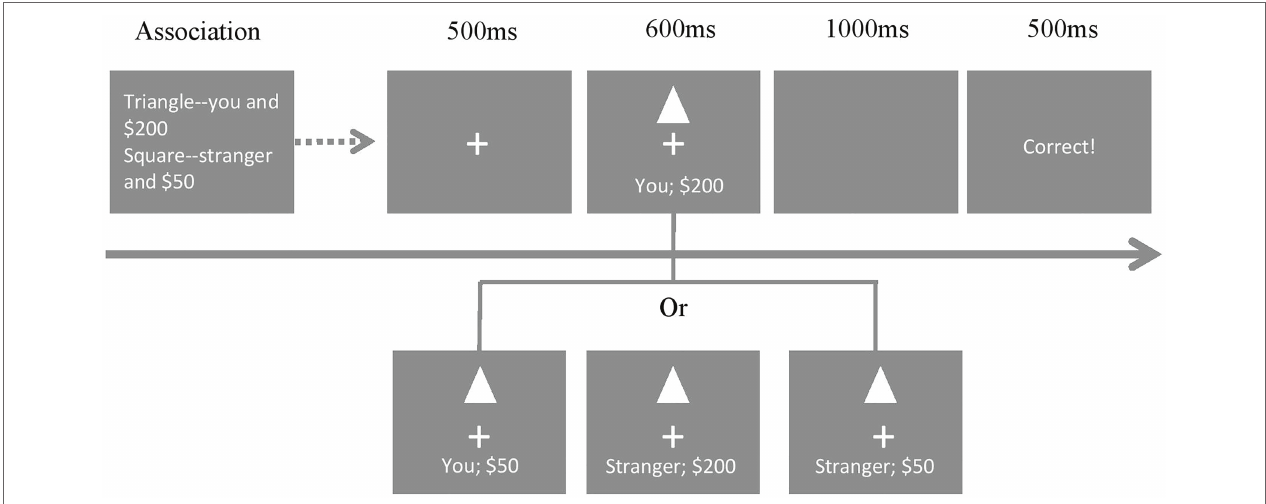
FIGURE 1 | Experimental procedure. This procedure is an example of the condition of double salience. The triangle represents self-high reward shapes with double matching (“you and $200”), single matching (“you and $50” or “a stranger and $200), and non-matching (“a stranger and $50)